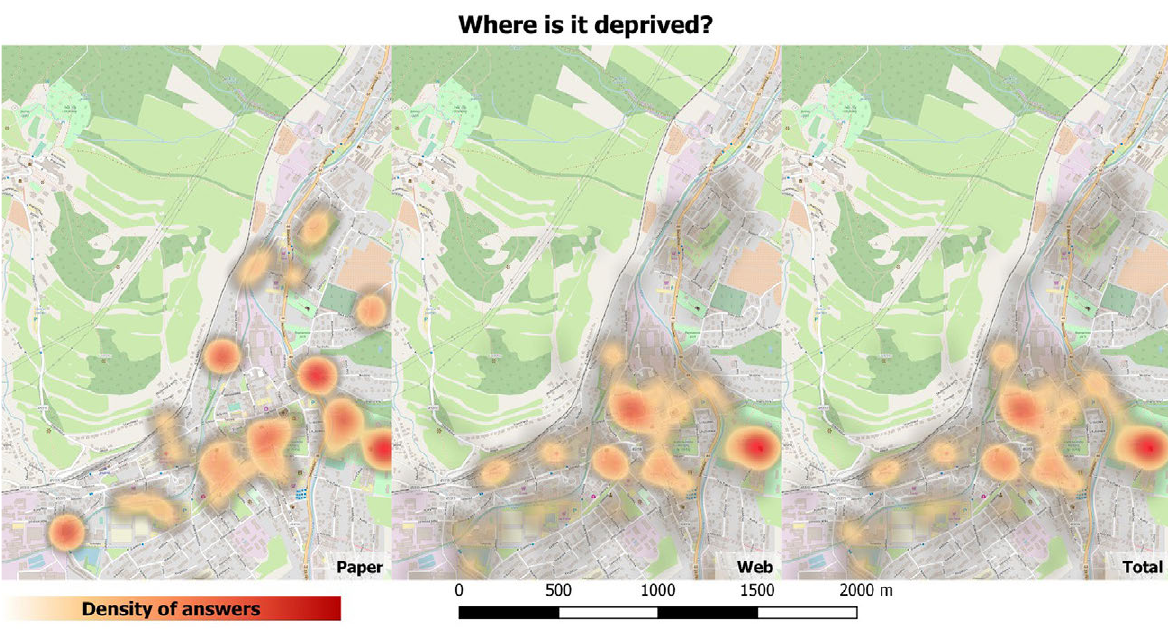
Fig. 6. Where do respondents think it is deprived in